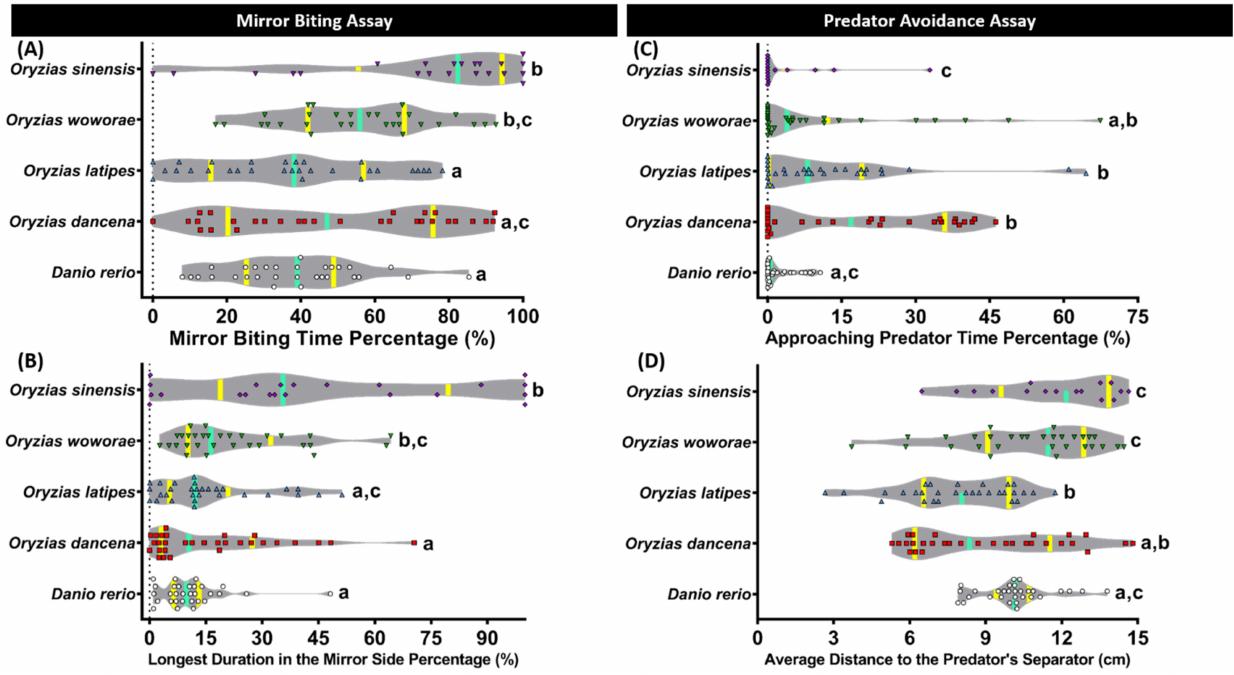
Figure 2. Mirror biting and predator avoidance behavior comparisons between each tested fish species (medaka and zebrafish). ( A ) Mirror biting time percentage and ( B ) longest duration on the mirror side percentage were analyzed in the mirror biting assay ( n = 30 for zebrafish, O. dancena , O. latipes , and O. woworae ; n = 22 for O. sinensis ). ( C ) Approaching predator time percentage and ( D ) average distance to the predator’s separator were analyzed in the predator avoidance assay ( n = 30 for zebrafish, O. dancena , O. latipes , and O. woworae ; n = 16 for O. sinensis ). The data were analyzed by the Kruskal–Wallis test continued with uncorrected Dunn’s test. Different letters (a, b, c) on the error bars represent a significant statistical difference ( p < 0.05). The violin plot’s median and interquartile were labeled with the bold line colored with cyan and